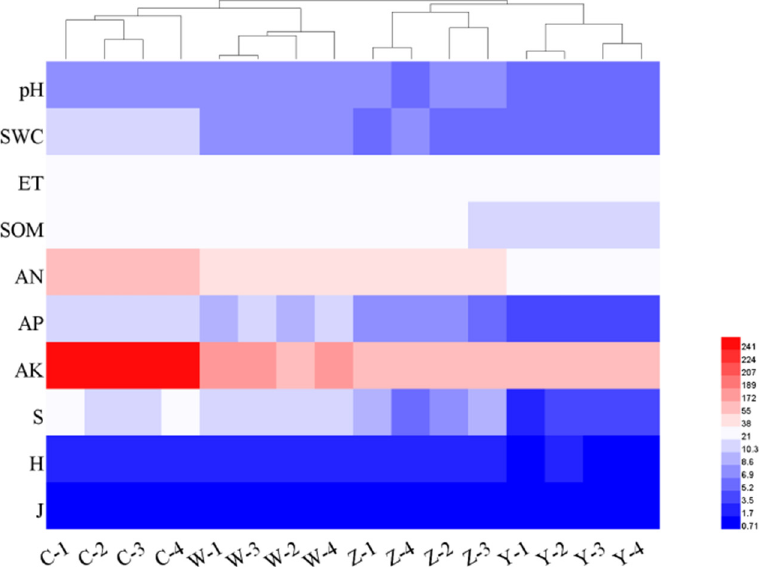
Figure 13. Clustering heat map of coal gangue pile plant and soil index. SWC: soil water content; ET: effective soil temperature; SOM: soil organic matter; AN: total nitrogen; AP: available phospho- rus; AK: available potassium; H : Shannon–Wiener index, J : Pielou’s index; S : Species abundance index. Euclidean distance was used for both row and column distance measurement.